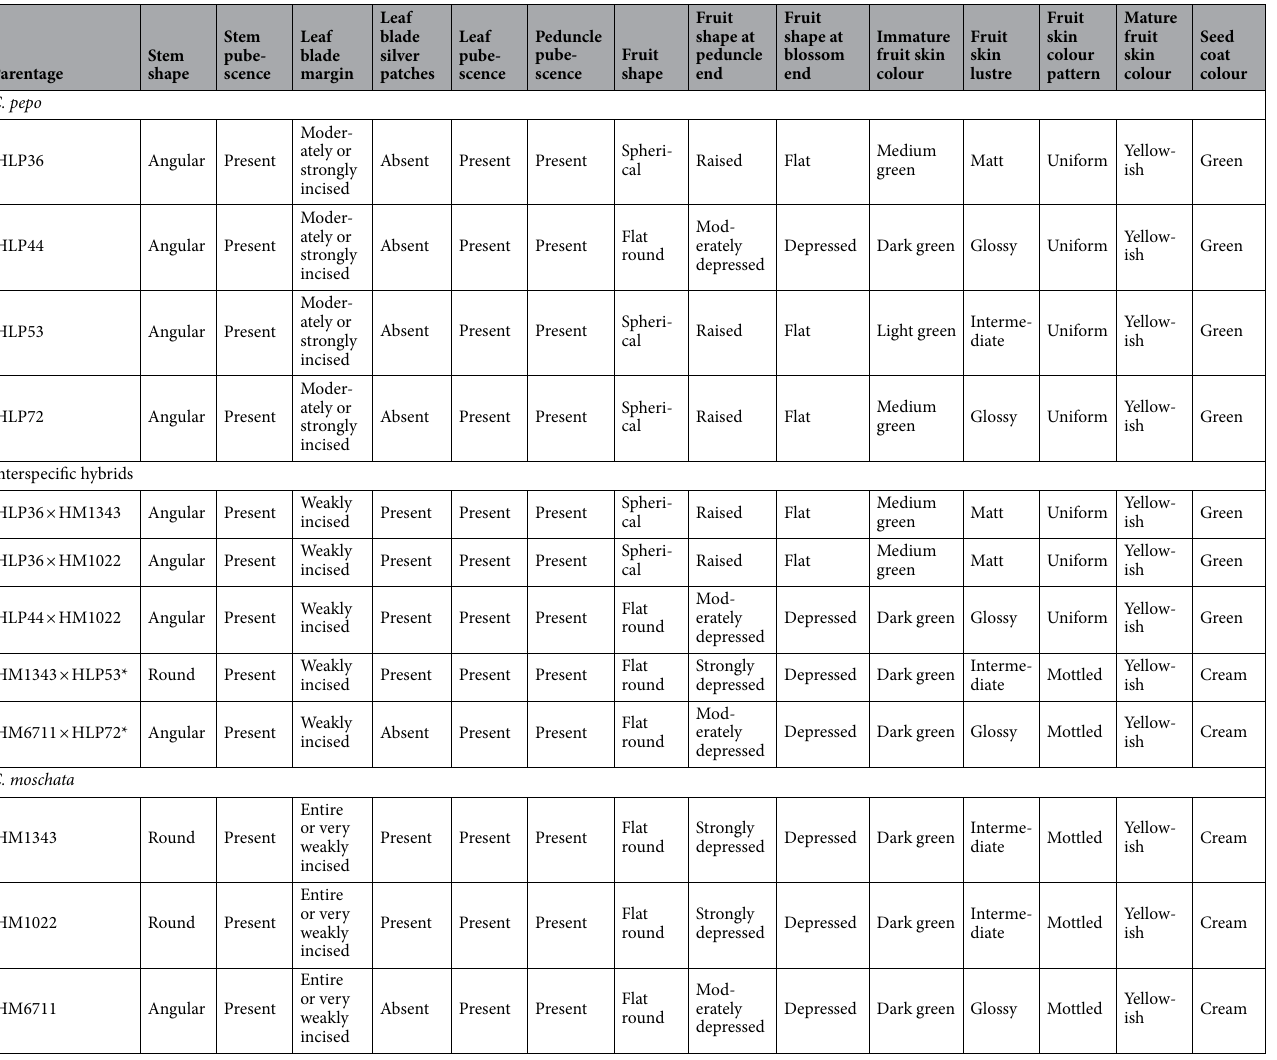
Table 3. Morphological (qualitative) characterization of interspecific hybrids and their parents. *Derived through ovule